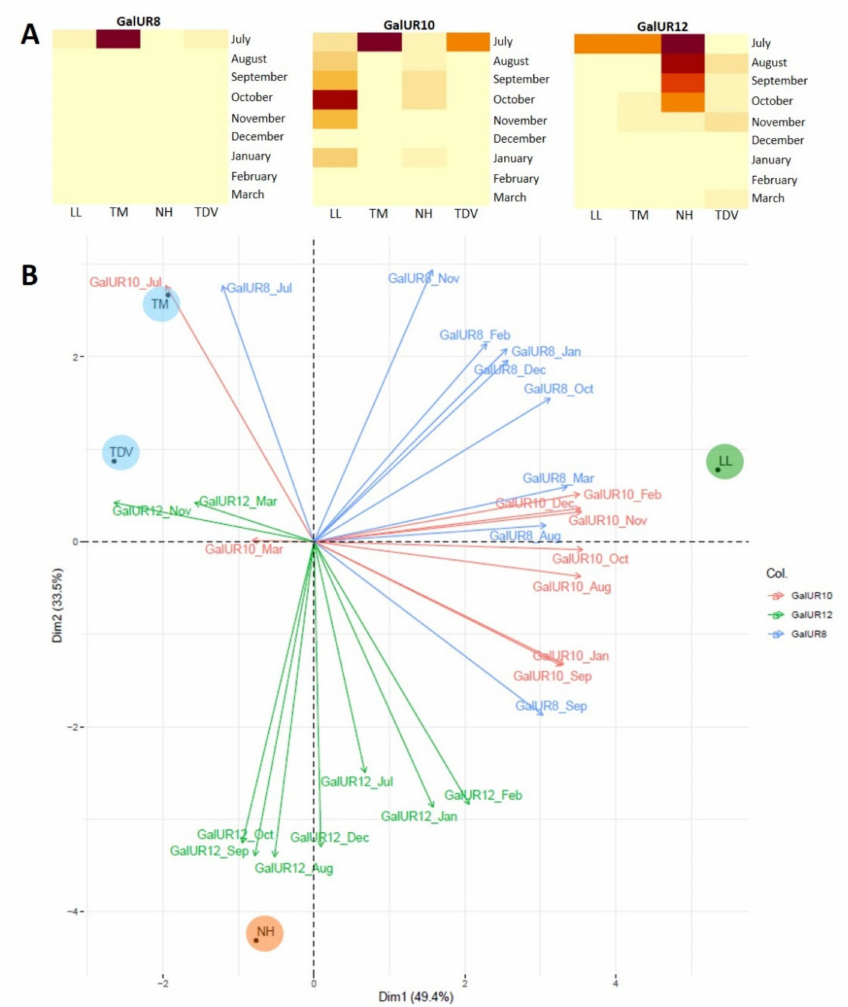
Figure 9. Heatmap ( A ) and PCA ( B ) of the gene expression data of three GalUR isoforms in the juice of Lanelate (LL), Tarocco Meli (TM), Newhall (NH), and Tarocco TDV (TDV). In the heatmap, gene expression decreases according to the colour scale, from rust red to creamy yellow. In the PCA, each isoform is a different colour. Varieties are indicated in coloured